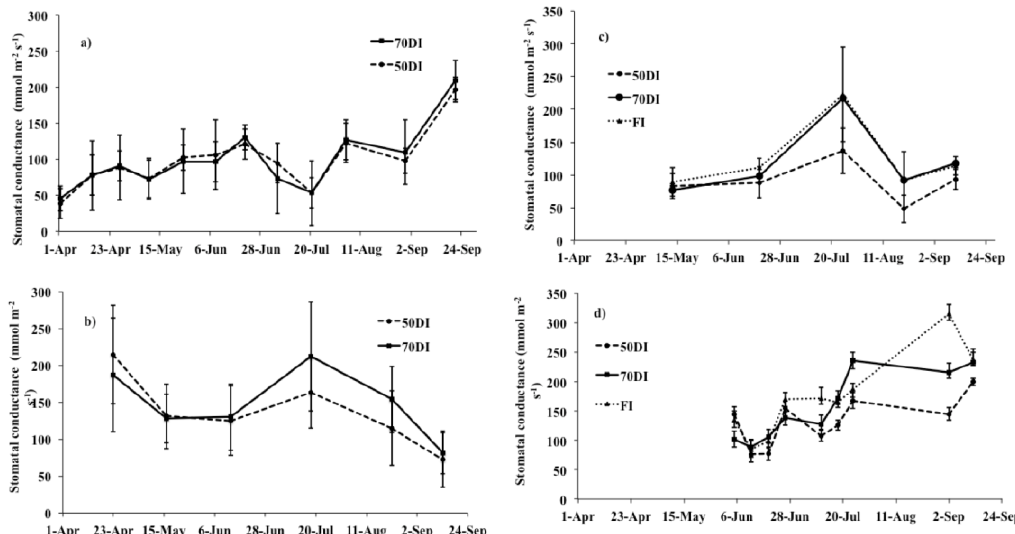
Figure 5. Leaf stomatal conductance obtained with a porometer for: ( a ) 2011, in DI treatments; ( b ) 2012, in DI treatments; ( c ) 2013, in all irrigation treatments; ( d ) 2014, in all irrigation treatments.